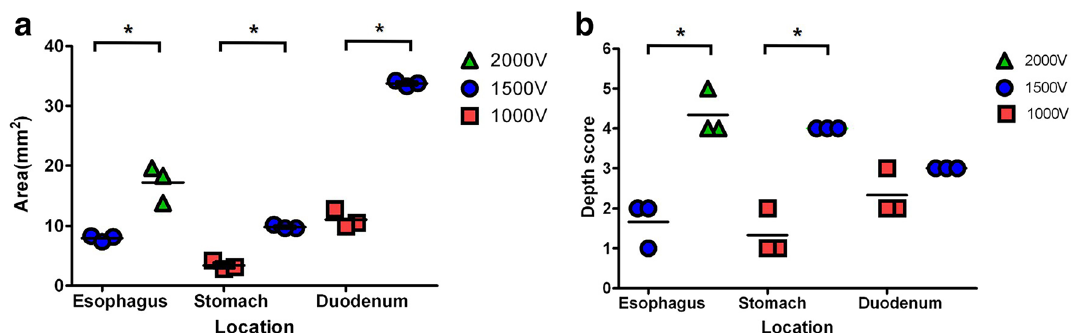
Figure 4. Comparison of scatter plot of electroporated area and depth by organ with electrical intensity in the phase 2 study. ( a ) Damaged surface area of the mucosa at 24 h after irreversible electroporation using the Image J program (version 1.8, National Institutes of Health). ( b ) Histologic depth scoring as follows: 1, lamina propria; 2, muscularis mucosa; 3, submucosa 1 (half above); 4, submucosa 2 (half below); 5, muscularis propria. Bar indicates median (n = 3). The Mann–Whitney U test (*p < 0.05) was